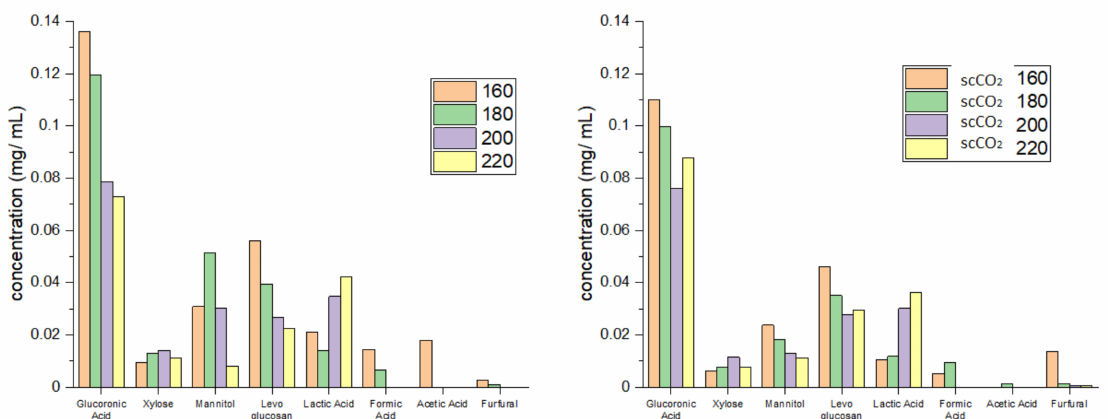
Figure 4. Carbohydrate split obtained from HPLC for standard method ( left ) and supercritical method ( right ). The numbers 160, 180, 200 and 220 refer to the microwave processing temperature ( ◦ C). NB. ‘Standard’ refers to without any scCO 2